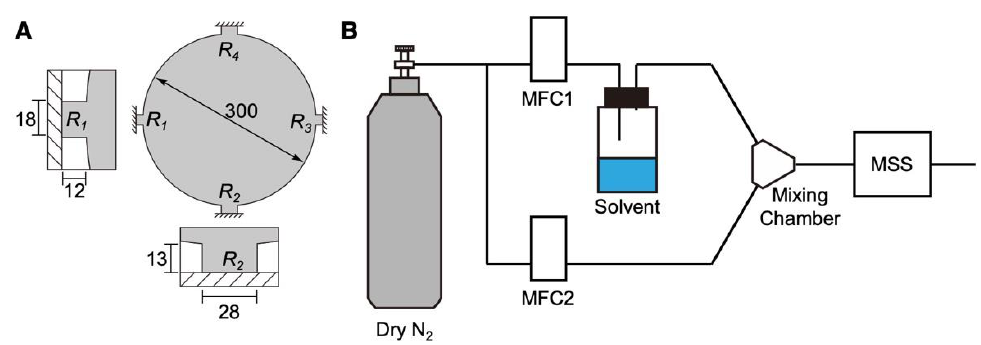
Figure 1. Schematic illustrations of the MSS and its sensing system. ( A ) Configuration of the MSS. Sensing beams with embedded piezoresistors are magnified in the insets. Numbers indicate the dimensions in µm. ( B ) Schematic illustration of the measurement system.